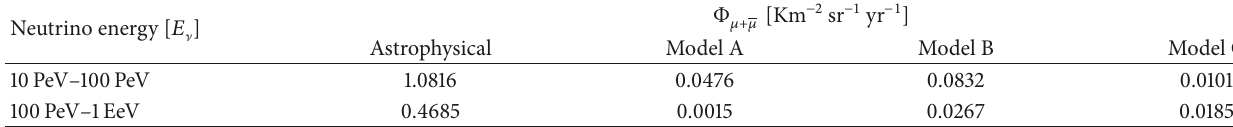
Table 5: Muon charged lepton fluxes ( Φ 𝜇+𝜇 ) produced by neutrino-nucleon interactions in “standard rock” with average width 𝐴 . The astrophysical flux is obtained from the extrapolation of the measured neutrino flux by IceCube. See the text for details. Neutrino energy [ 𝐸 ] ]